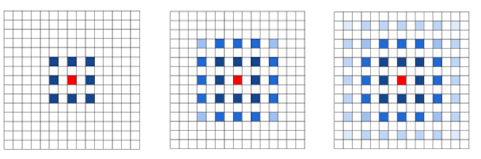
Figure 6. “Gridding Effect” of atrous convolution.